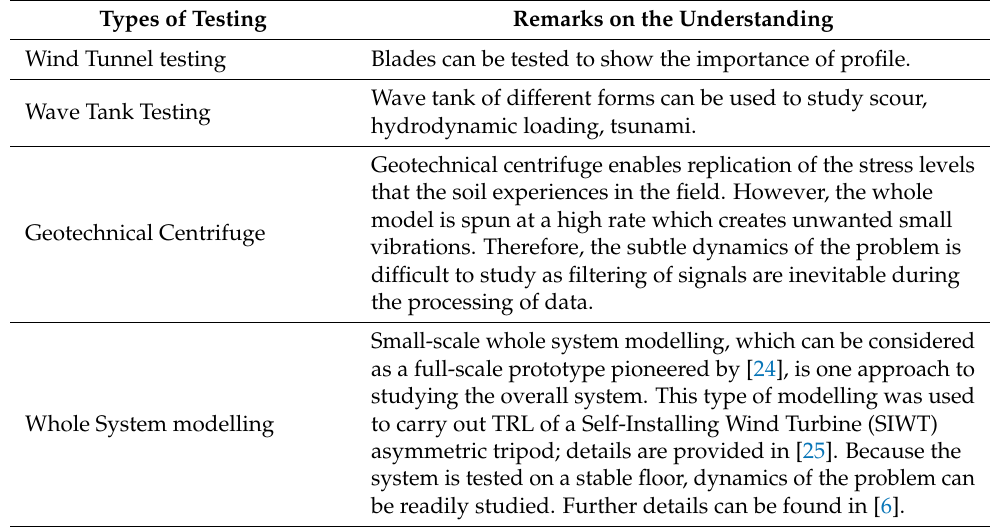
Table 2. Different forms of testing for offshore wind